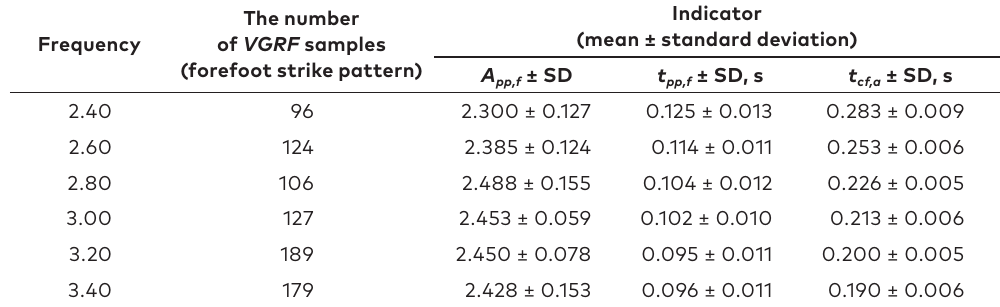
Table 2. The VGRF/G curve indicators – forefoot strike running (mean value ± standard deviation